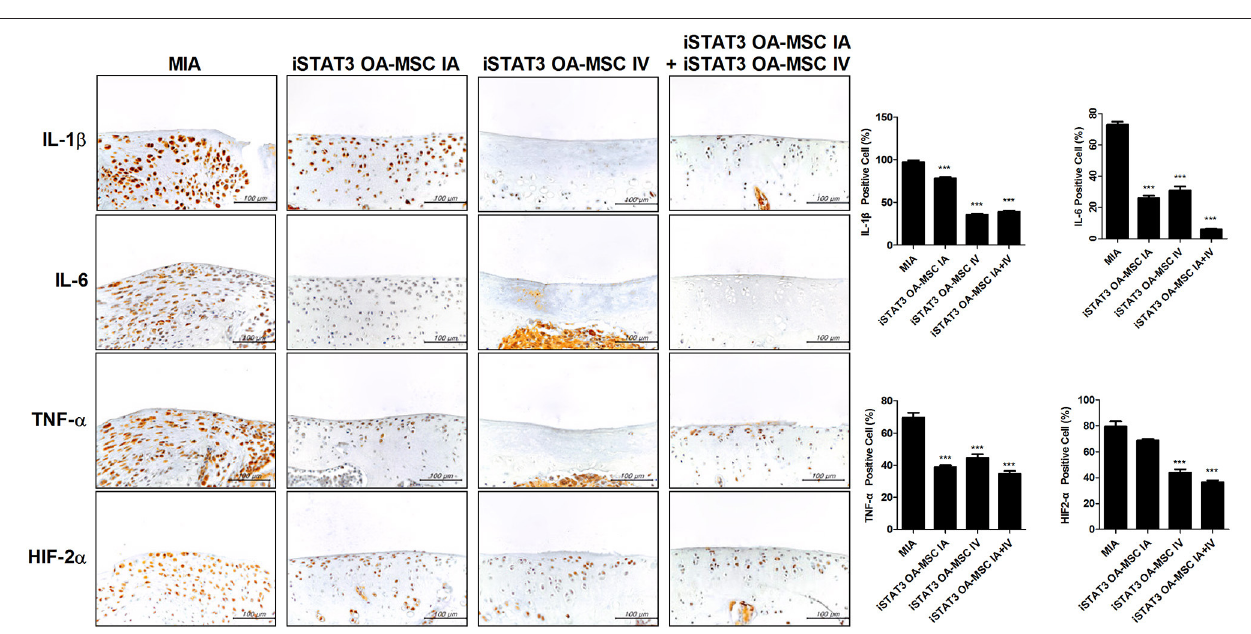
FIGURE 5 | (B,C) Histochemical analysis of femoral condyle (B) and severity scores (C) after IA and IV co-administration of iSTAT3-OA MSCs in MIA-induced OA rats. (B) OA was induced in Wistar rats by IA injection of MIA. OA Rats were injected multiple times with IA and IV co-administration of iSTAT3 OA-MSCs (3 × 10 5 ). Knee